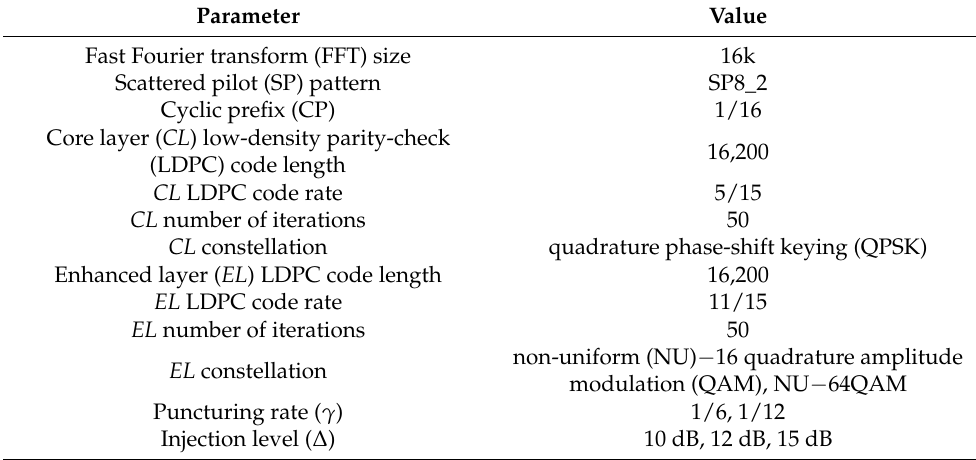
Table 2. Basic transmission parameters.